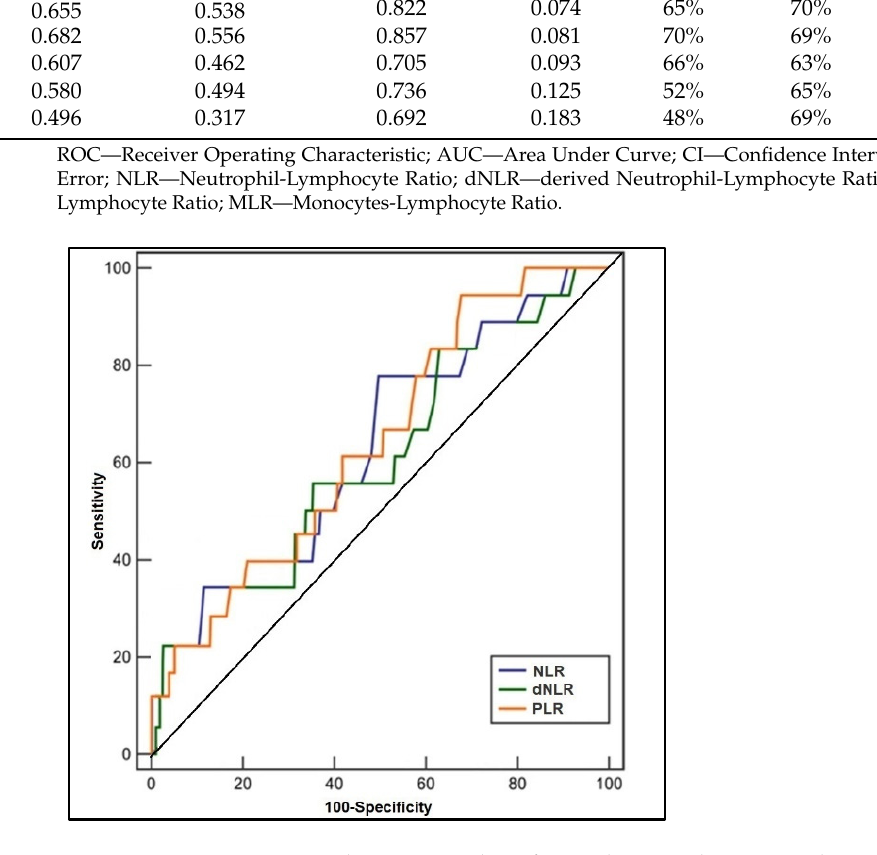
Figure 2. Receiver operating characteristic plots of NLR, dNLR, and PLR in predicting premature birth.